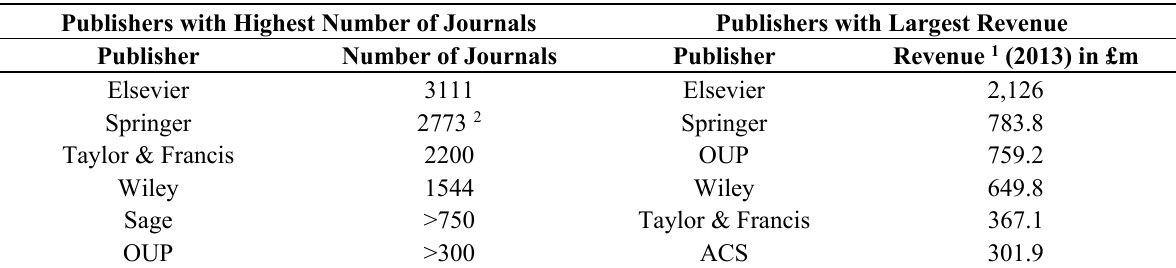
Table 1. Largest toll-access